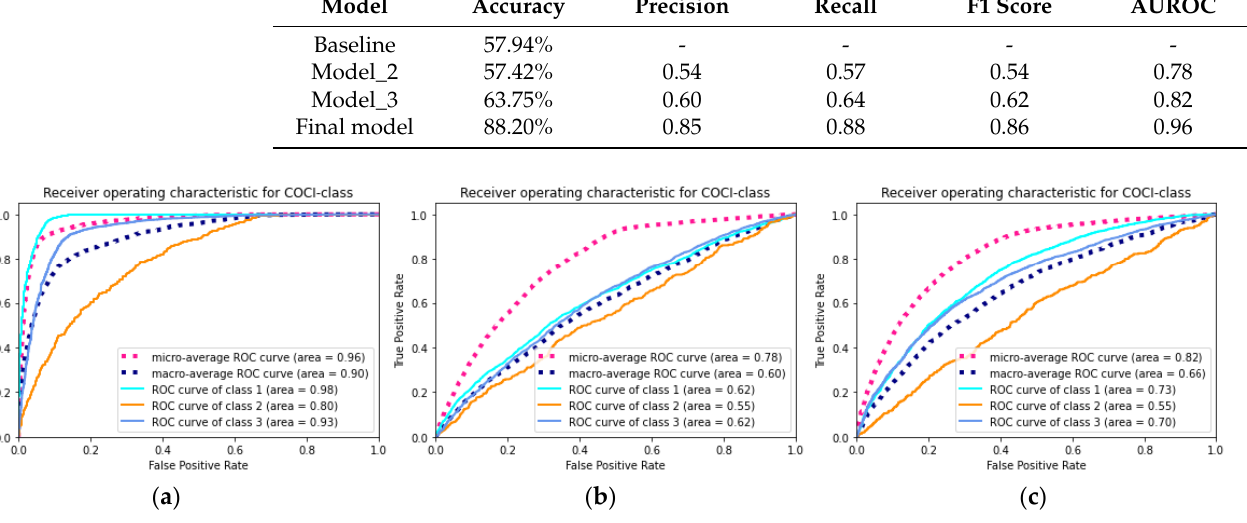
Figure 4. The receiver operating characteristic curve of the models. ( a ) The final model built by full features; ( b ) the model_2 built by only demographic features; ( c ) the model_3 built by demographic and comorbidity features.